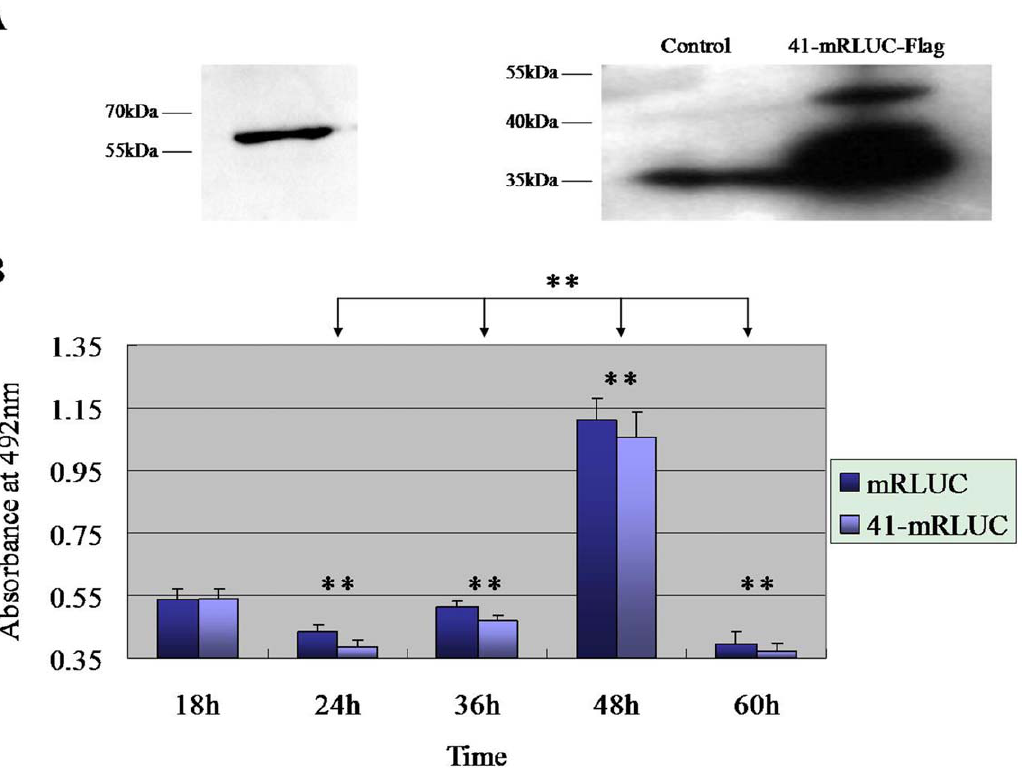
Figure 4. Effect of the nonphosphorylated peptide 41 on the proliferation of the SK-BR-3 breast cancer cells. A ) Protein expression. The endogenous Grb7 protein expression (left) and expression of the fusion protein of 41-mRLUC-3 6 Flag (right) in the SK-BR-3 breast cancer cells were identified by western blot. B ) SK-BR-3 breast cancer cell proliferation analysis. Double-factor variance analysis was performed to analyze the differences between the adjusted absorbance and different transfected cell groups, and between the adjusted absorbance and different time points. Statistically significant differences existed in both of groups (n=10, p , 0.001).